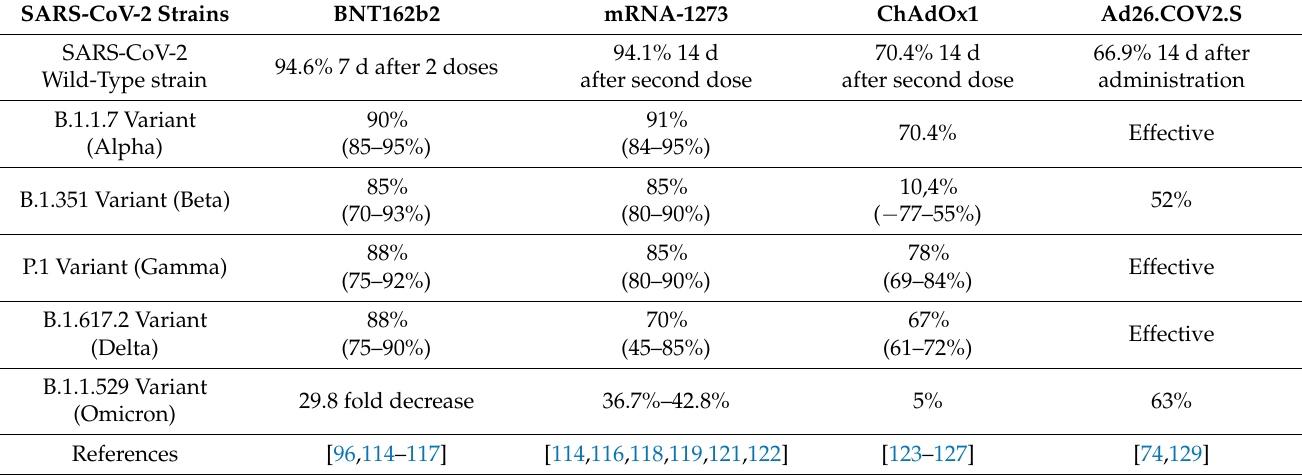
Table 2. Effect of variants on vaccine